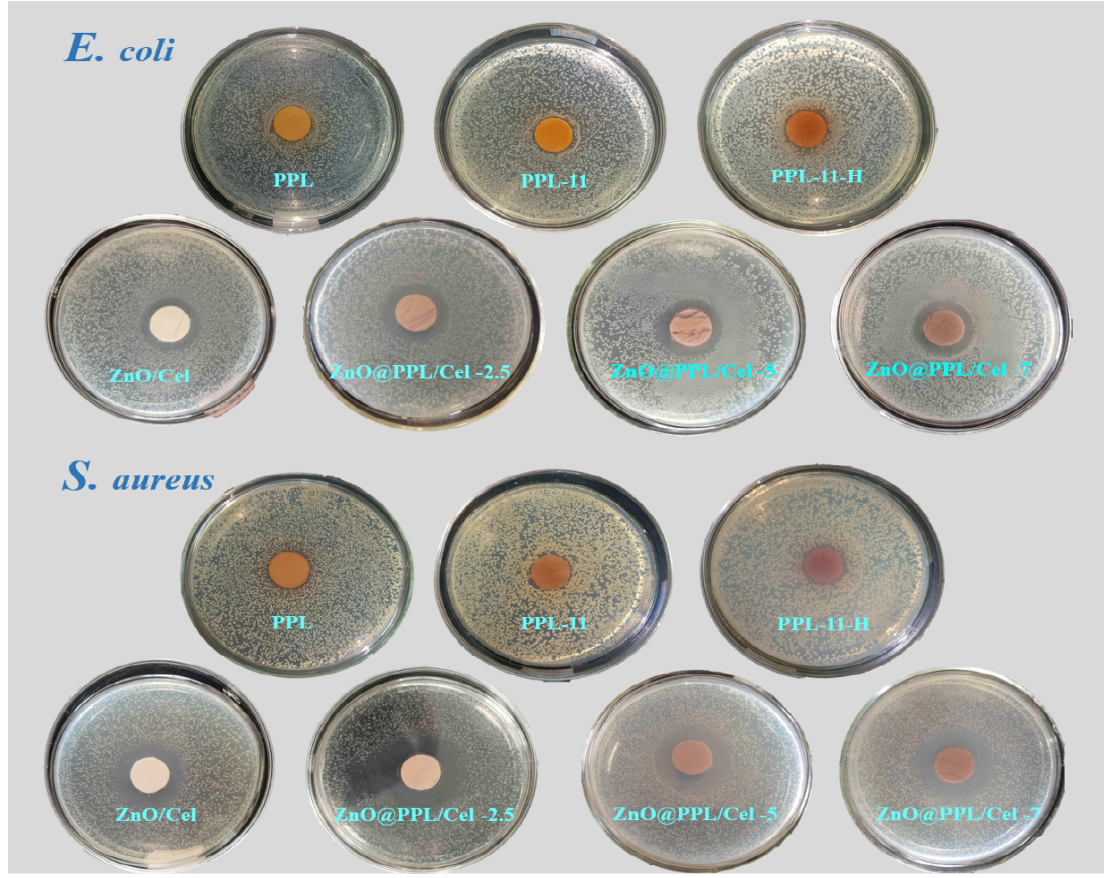
Table 1. Inhibition zones of ZnO/Cel and ZnO@PPL/Cel.